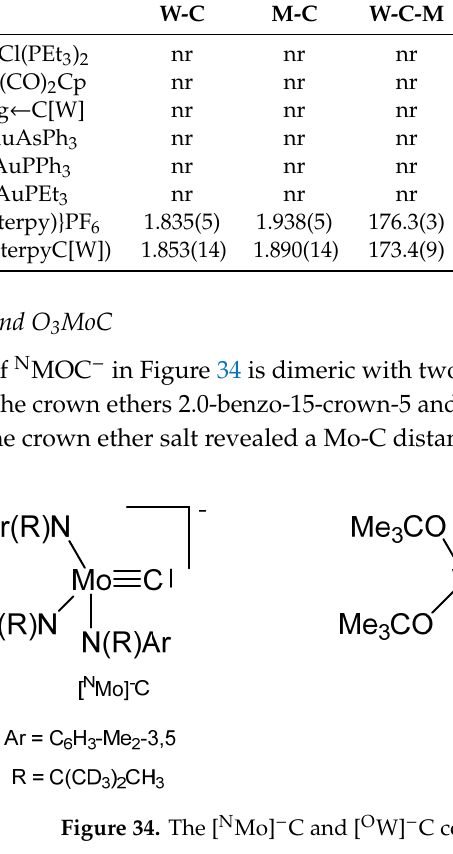
177(2) ° [127]. 3.10. Symmetrically Bridged Carbido Complexes M=C=M 3.10.1. The Fe=C=Fe Core [Fe(TPP)] 2 C was obtained from Fe III (TPP)Cl in the presence of iron powder by reacting with CI 4 (TPP = 5, 10, 15, 20-tetraphenylporphyrin; according to Fe II the complex is diamagnetic